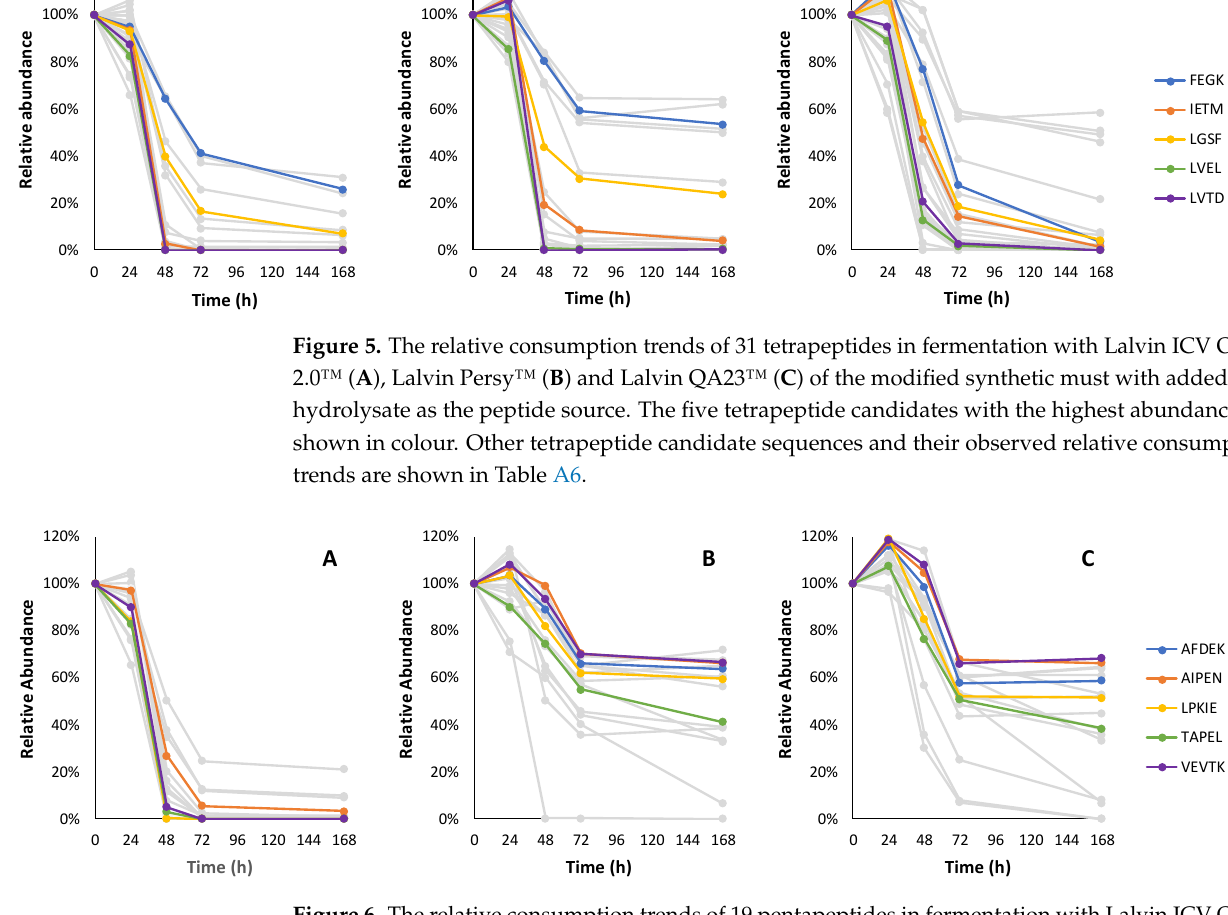
Figure 7. The relative consumption trends of 13 hexapeptides in fermentation with Lalvin ICV Opale 2.0™ ( A ), Lalvin Persy™ ( B ) and Lalvin QA23™ ( C ) of the modified synthetic must with added BSA hydrolysate as the peptide source. The five hexapeptide candidates with the highest abundance are shown in colour. Other hexapeptide candidate sequences and their observed relative consumption trends are shown in Table A8. *DTHKSE elutes within the void volume. Figure 8. F ree amino acid consumption trends in fermentations with Lalvin ICV Opale 2.0™ ( A ), Lalvin Persy™ ( B ) and Lalvin QA23™ ( C ) of the modified synthetic must with (solid line) and with- out (dashed line) added BSA hydrolysate as the peptide source. 3.4. Untargeted Peptide Analysis The results of the untargeted data analysis (using the PQI_CS_Peptides database) were compared against the results obtained by peptide mapping to assess the identifica- tion accuracy of the untargeted workflow.